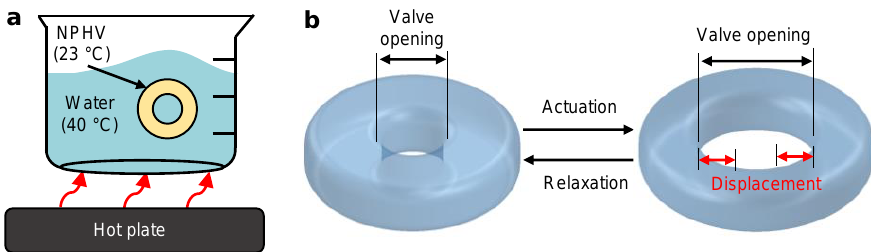
Figure 3. Actuation of the NPHV. ( a ) Schematic showing the experimental set-up of the NPHV actuation. ( b ) Schematic demonstrating NPHV’s actuation